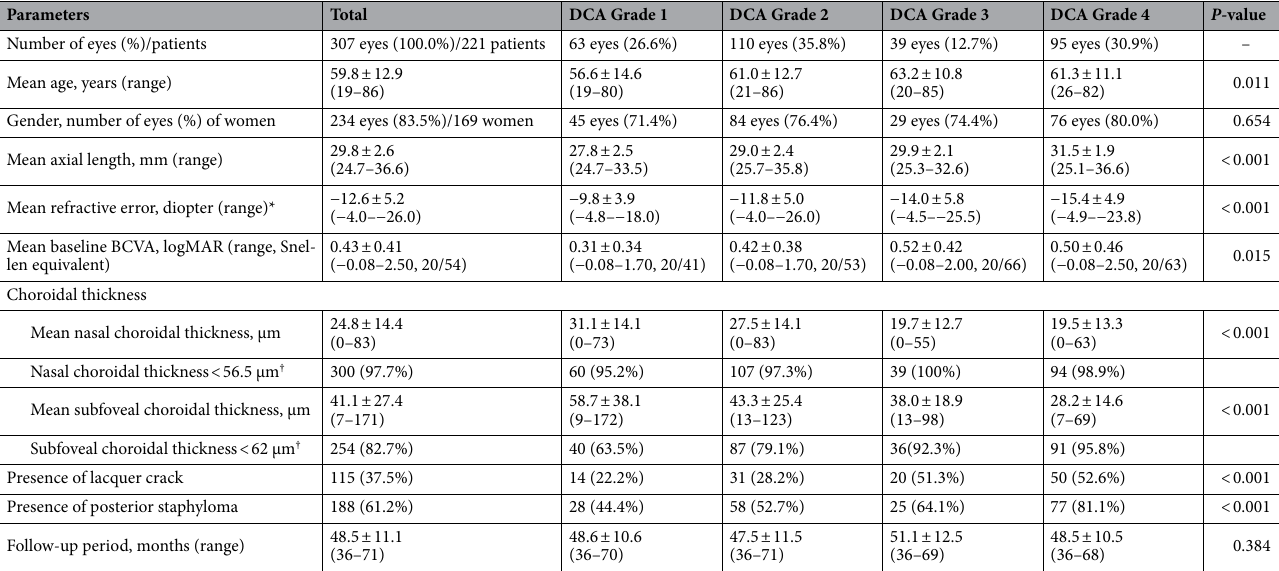
Table 1. Baseline characteristics and Demographics of patients according to the baseline grades of diffuse chorioretinal atrophy. DCA = Diffuse chorioretinal atrophy; BCVA = best-corrected visual acuity; logMAR = logarithm of minimal angle of resolution. *Phakic eyes without history of refractive surgery. † Optimal cut-off values of nasal choroidal thickness (< 56.5 μm) to predict the presence of peripapillary DCA and subfoveal choroidal thickness (< 62 μm) to predict the presence of macular DCA suggested in an optical coherence tomography-based study 9 .